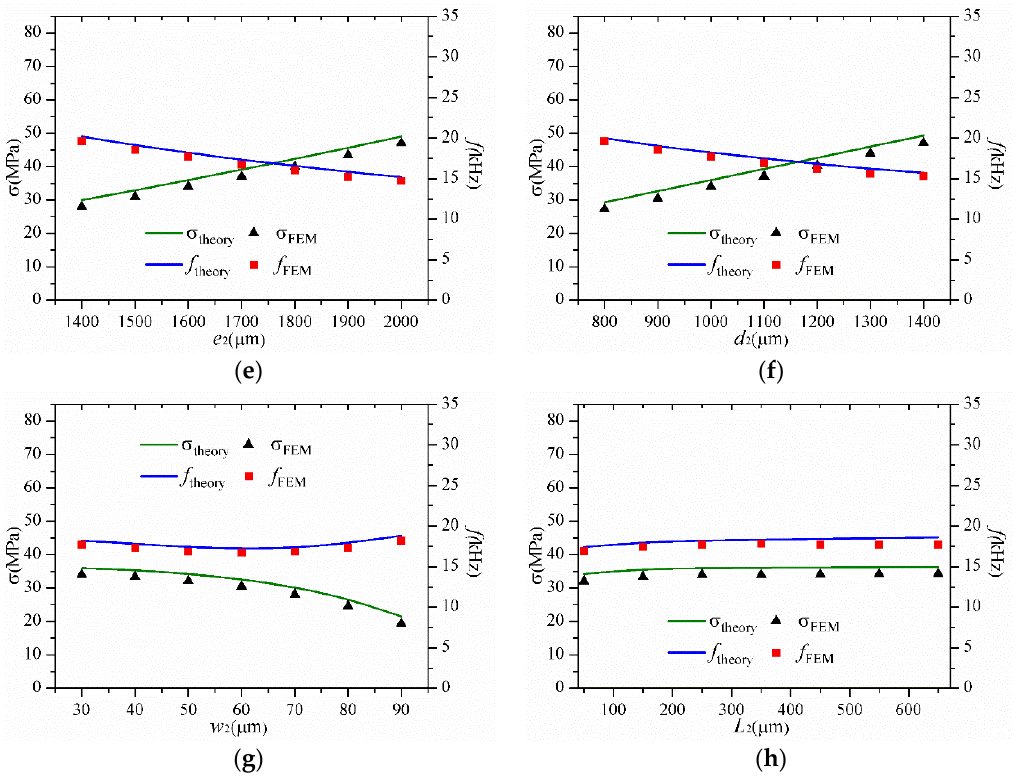
Figure 5. The effects of different geometrical parameters on σ and f. ( a ) The effect of w 1 ; ( b ) The effect of L 1 ; ( c ) The effect of e 1 ; ( d ) The effect of d 1 ; ( e ) The effect of e 2 ; ( f ) The effect of d 2 ; ( g ) The effect of w 2 ; ( h ) The effect of L 2 .